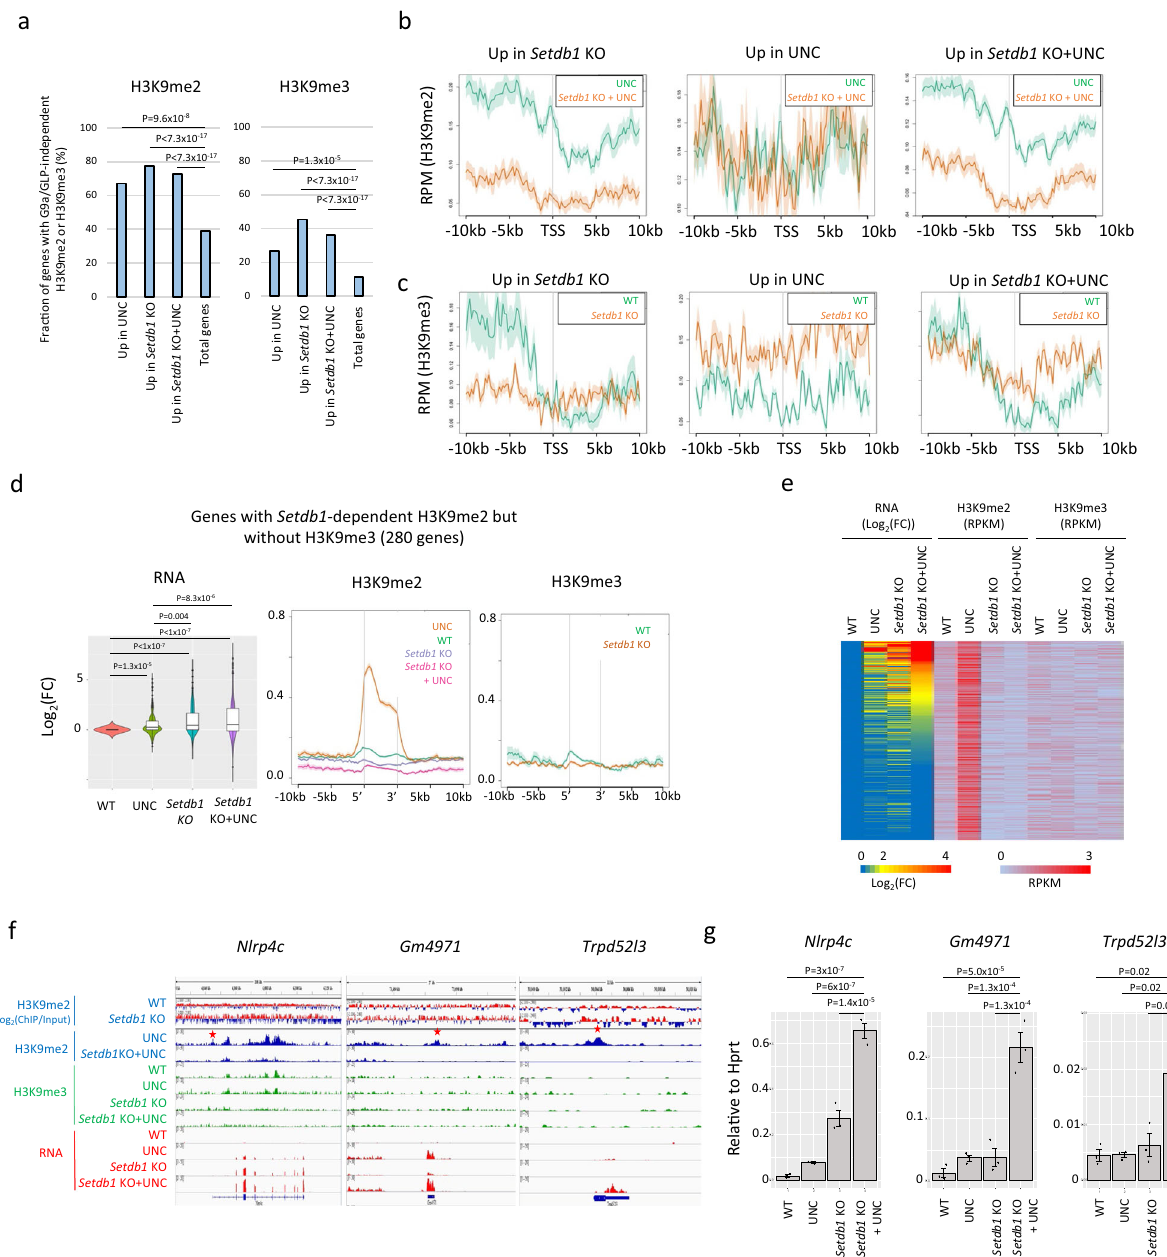
Fig. 4 Function of G9a/GLP-independent H3K9me2 in transcriptional regulation. a Overlap of upregulated genes with G9a/GLP-independent H3K9me2 or H3K9me3 domains. The graph shows the fractions of upregulated genes in each condition that overlap with G9a/GLP-independent H3K9me2 domains or H3K9me3 domains within 5 kb of TSS. Signi fi cant enrichment of H3K9me2 around TSS was calculated by hypothesis testing for the difference in the population proportions using a function of prop.test in R. b , c Enrichment of H3K9me2 in WT or Setdb1 mESCs treated with UNC0642 ( b ) and enrichment of H3K9me3 in WT or Setdb1 KO mESCs ( c ) around upregulated genes in each condition. G9a/GLP-independent H3K9me2 is enriched from upstream of TSS to gene body of upregulated genes identi fi ed in Setdb1 KO mESCs treated with or without UNC0642. This H3K9me2 is largely dependent on SETDB1. d Expression and H3K9 methylation pro fi les of genes with SETDB1-dependent H3K9me2 but without H3K9me3. The boxplot shows log2 fold change of expression. The Middle and right fi gures show the enrichment of H3K9me2 and H3K9me3 around the TSS in WT or Setdb1 KO mESCs treated with or without UNC0642, respectively. e Heatmap of fold change of expression, H3K9me2 RPKM, and H3K9me3 RPKM in genes with H3K9me2 but without H3K9me3. H3K9me2 and H3K9me3 RPKM were calculated ~0.5 kb of the TSS. f Representative genes with G9a/GLP-independent H3K9me2 but without H3K9me3. H3K9me2, H3K9me3, and RNA-seq pro fi les of Nlrp4c, Gm4971, and Trpd52I3. H3K9me2 in WT and Setdb1 KO mESCs shows as log 2 (ChIP/ Input). Star mark represents SETDB1-dependent H3K9me2 around TSS. g qRT-PCR of representative genes shown in Fig. 4f. Bar graph shows the